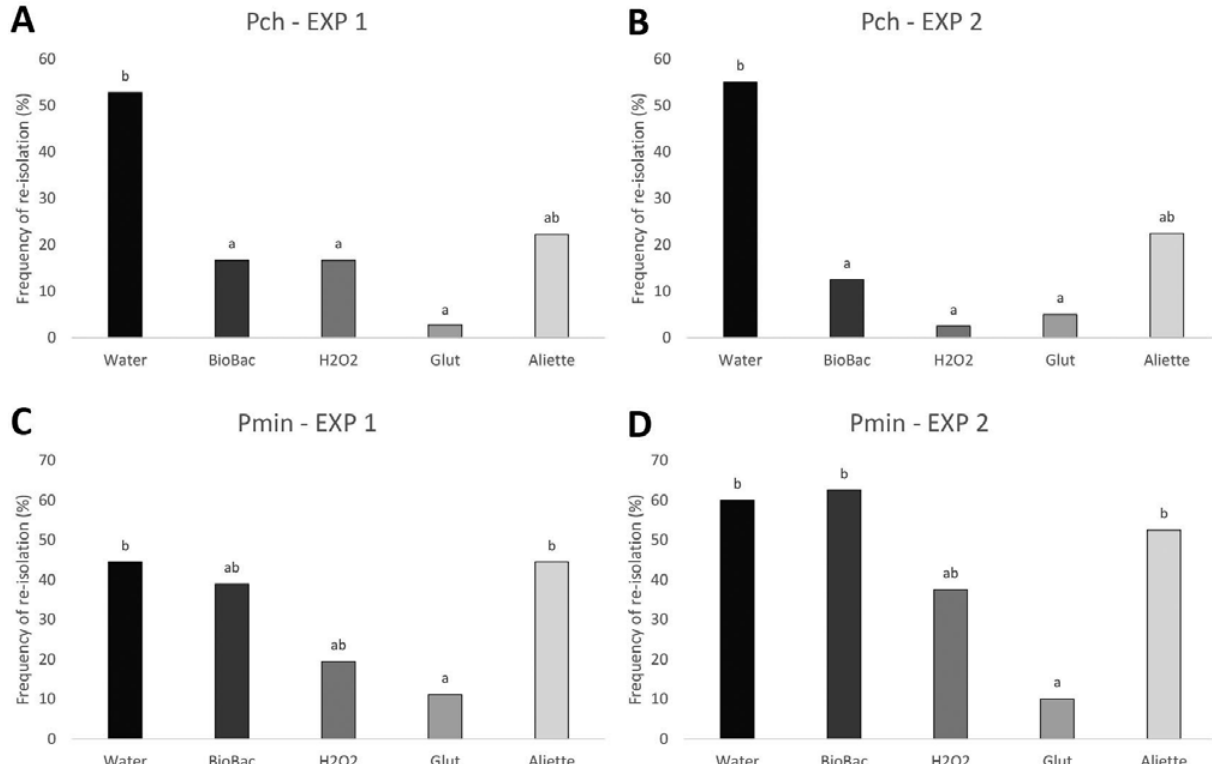
Figure 2. Frequency of re-isolation (%) of Pa. chlamydospora (Pch; A, B) or Pm. minimum (Pmin; C, D), 1 month after endothera- py with either water (negative control), elemental silver (BioBac), hydrogen peroxide (H 2 O 2 ), glutaraldehyde (Glut) or fosetyl- Al (Aliette). The experiment conducted in 2016 (EXP 1) used mycelium plug inoculum (A, C), while that in 2017 (EXP 2) used conidia inoculum (B, D). Bars accompanied by the same letter do not differ significantly ( P < 0.05) according to Tukey’s